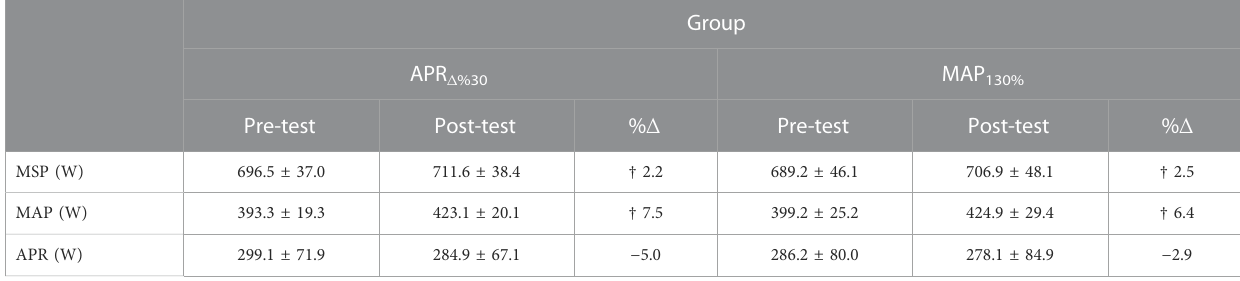
TABLE 1 Maximal sprinting power (MSP) and anaerobic power reserve (APR) before and after HIIT.